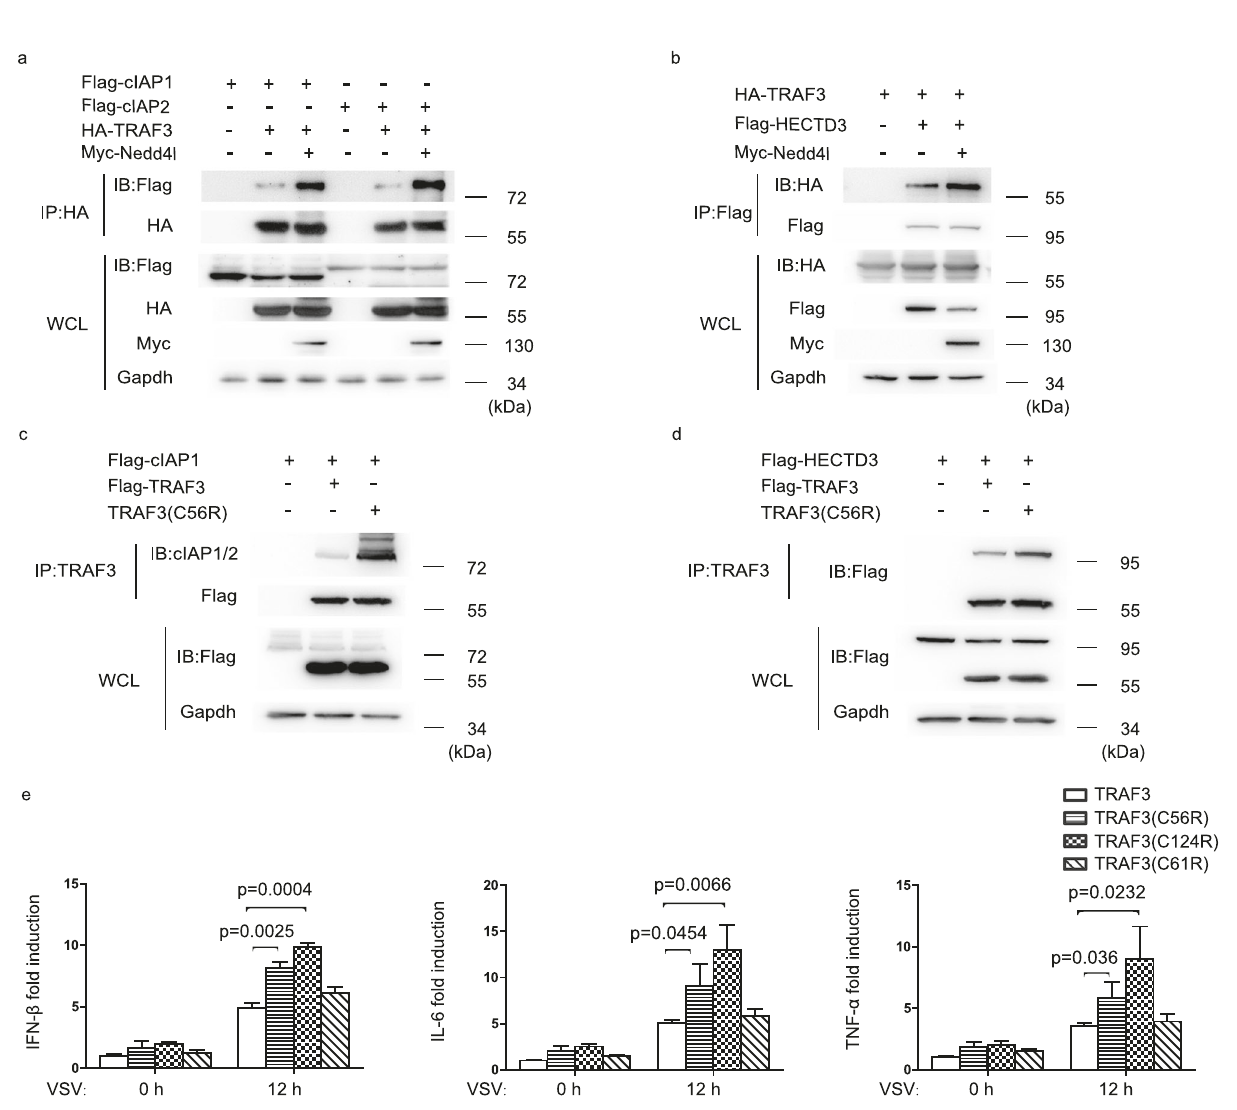
Fig. 7 Nedd4l promotes TRAF3 to associate with cIAP1/2 and HECTD3. a IB of Flag-cIAP1, Flag-cIAP2, Myc-Nedd4l, and HA-TRAF3 co- immunoprecipitated with anti-HA from lysates of 293T cells transfected with indicated plasmids. b IB of Flag-HECTD3, Myc-Nedd4l and HA-TRAF3 co- immunoprecipitated with anti-HA from lysates of 293T cells transfected with indicated plasmids. c IB of Flag-cIAP1, Flag-TRAF3, and Flag-TRAF3(C56R) co-immunoprecipitated with anti-TRAF3 from lysates of 293T cells transfected with indicated plasmids. d IB of Flag-HECTD3, Flag-TRAF3 and Flag-TRAF3 (C56R) co-immunoprecipitated with anti-TRAF3 from lysates of 293T cells transfected with indicated plasmids. e RT-qPCR analysis of IFN- β , IL-6, and TNF- α mRNA expression in 293 cells transfected with plasmids expressing TRAF3 or mutant TRAF3 and then infected with VSV (MOI = 10) for 12 h. Data are presented as mean ± SD ( n = 3 per group) and p -values by two-tailed unpaired Student ’ s t -test are indicated in e. Results in ( a – e ) are representative of three independent